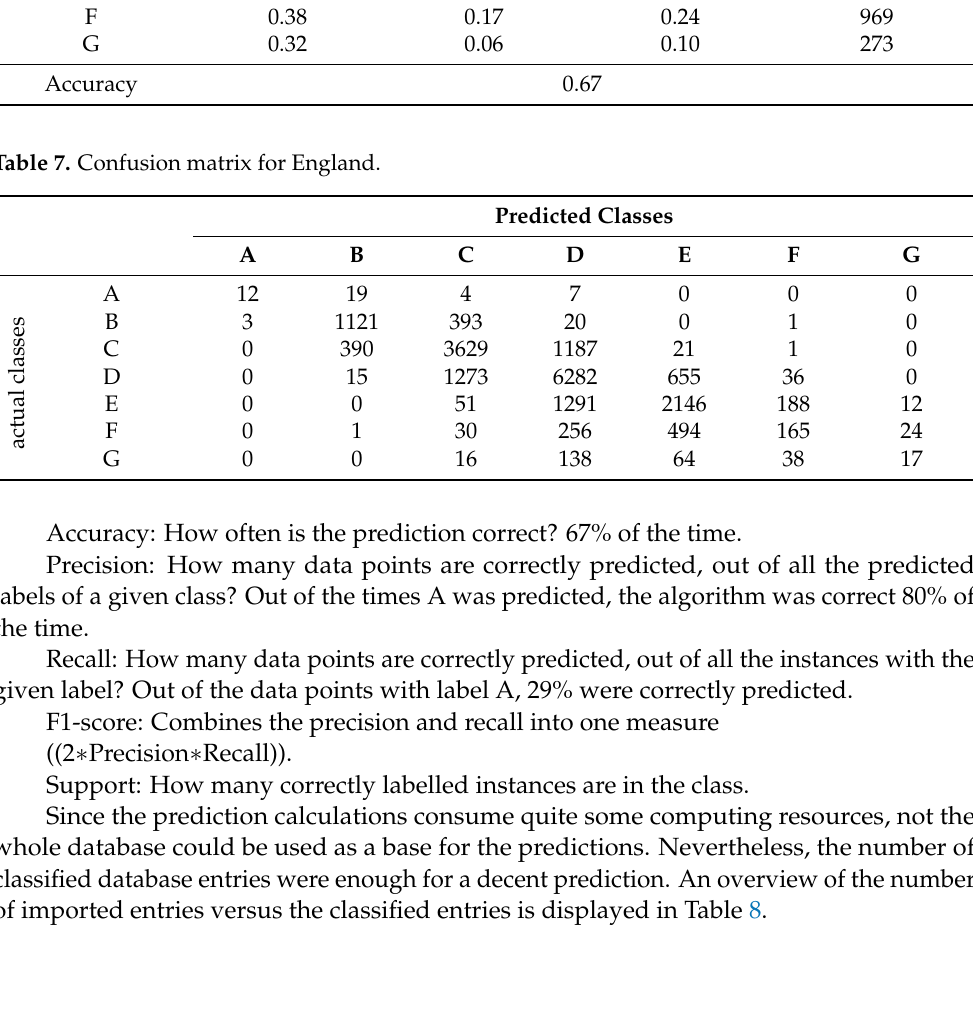
Table 6. Effectiveness metrics for England.